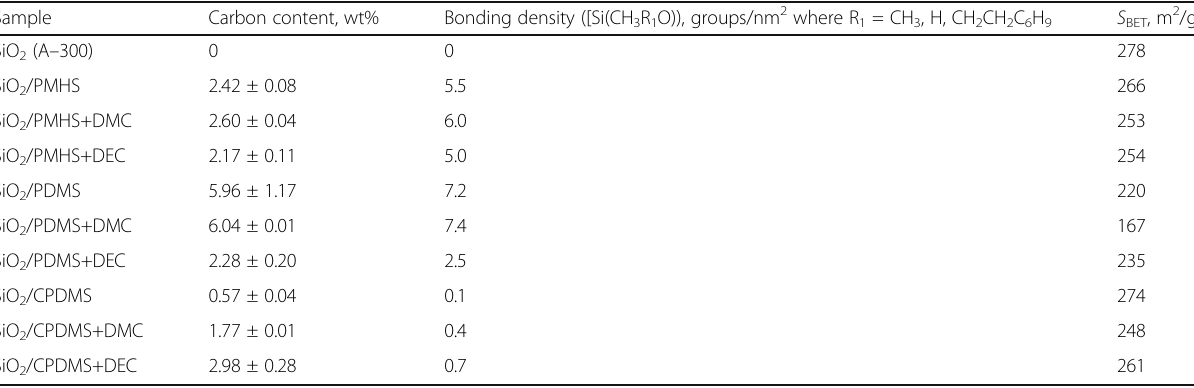
Table 1 Carbon content, bonding density, and surface area of grafted neat organosiloxanes and their mixtures with DMC or DEC at the SiO 2 surface